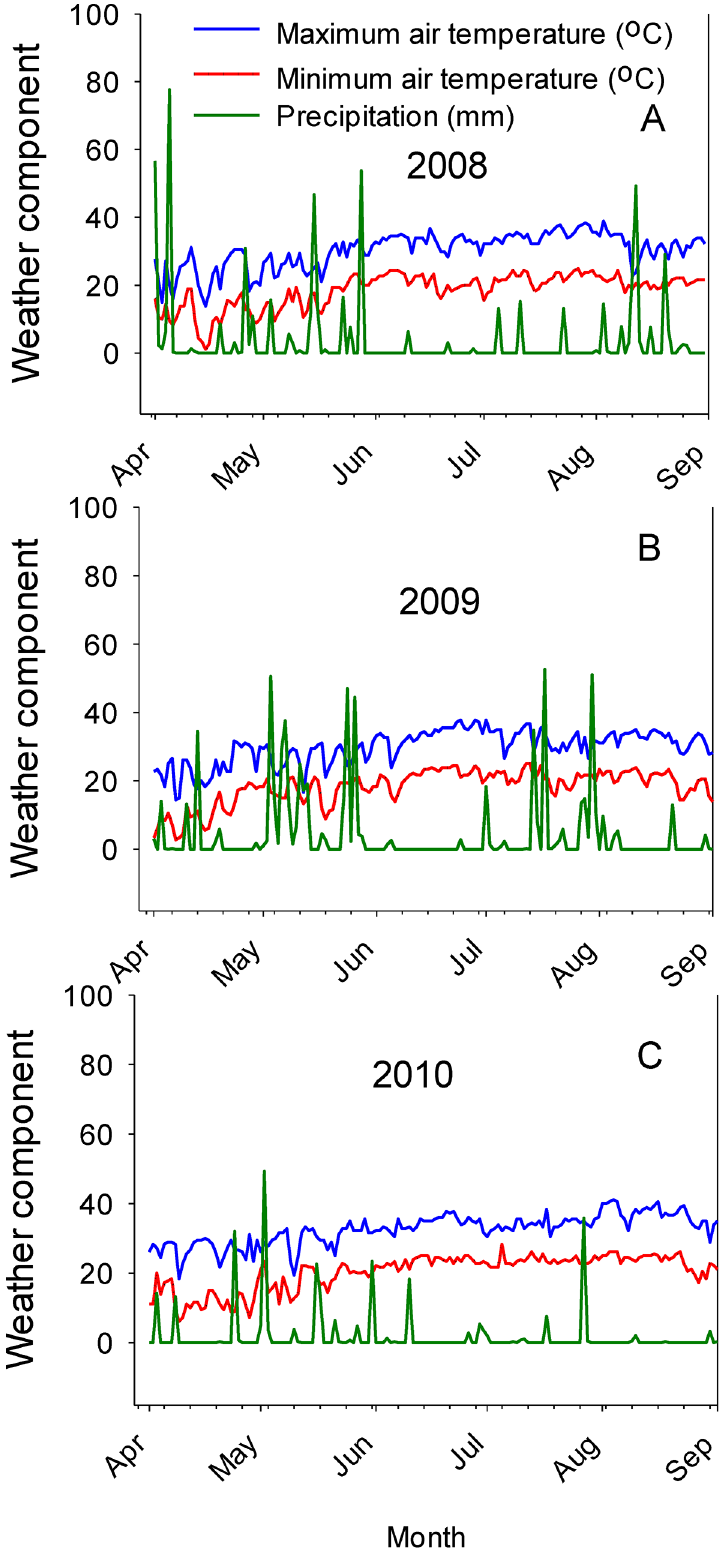
Fig 3. Weather components (minimum and maximum air temperature, and precipitation) in 2008 (A), 2009 (B), and 2010 (C). Weather data obtained from MSUCares